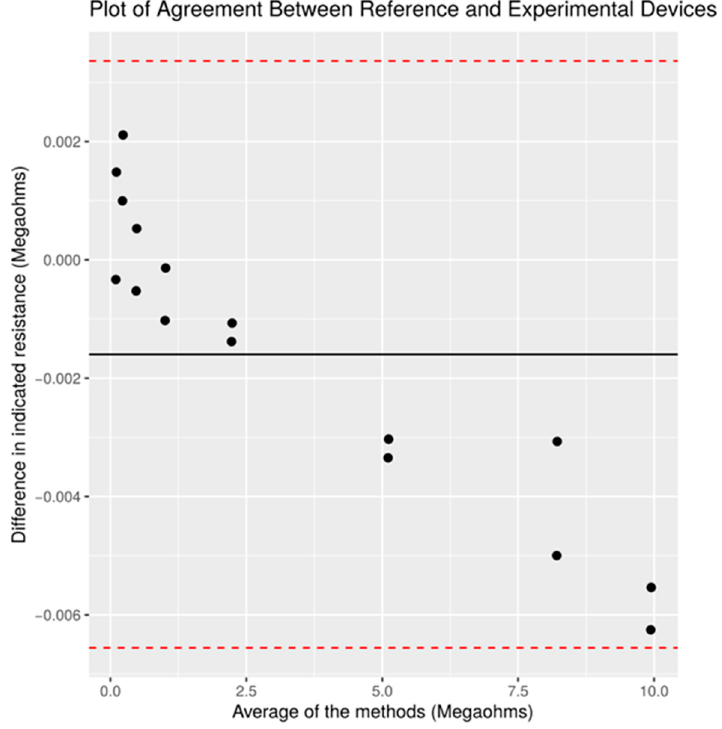
Figure 4. Bland–Altman plot of agreement between reference device and experimental transducer device.